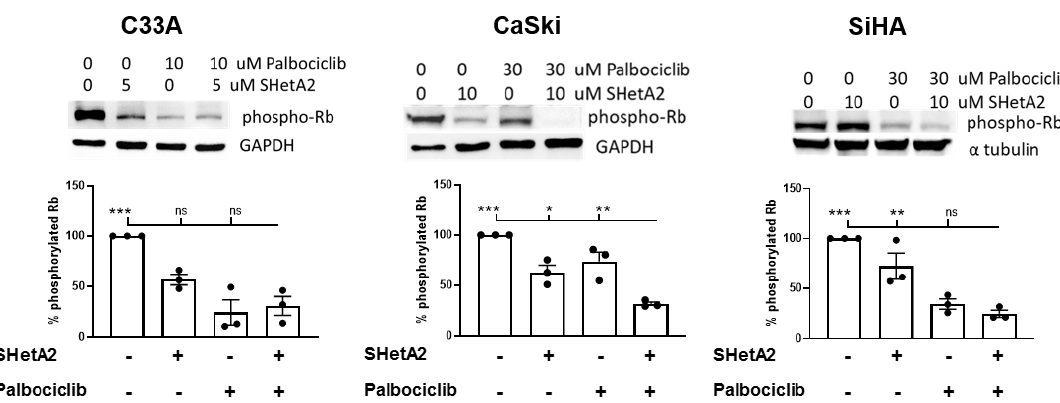
Figure 3. Phospho-Rb levels in cultures treated with the indicated concentrations of SHetA2, palbociclib or the combination of these two drug for 24 h. Representative western blots of the indicated cervical cancer cell lines are shown on top. Graphs of phospho-Rb band intensities in replicate experiments are show below. ANOVA comparison of combination treatment with other treatment groups: ns = not significant, * = p < 0.05, ** = p < 0.01, *** p < 0.001. The whole Western Blot see Figure S3.